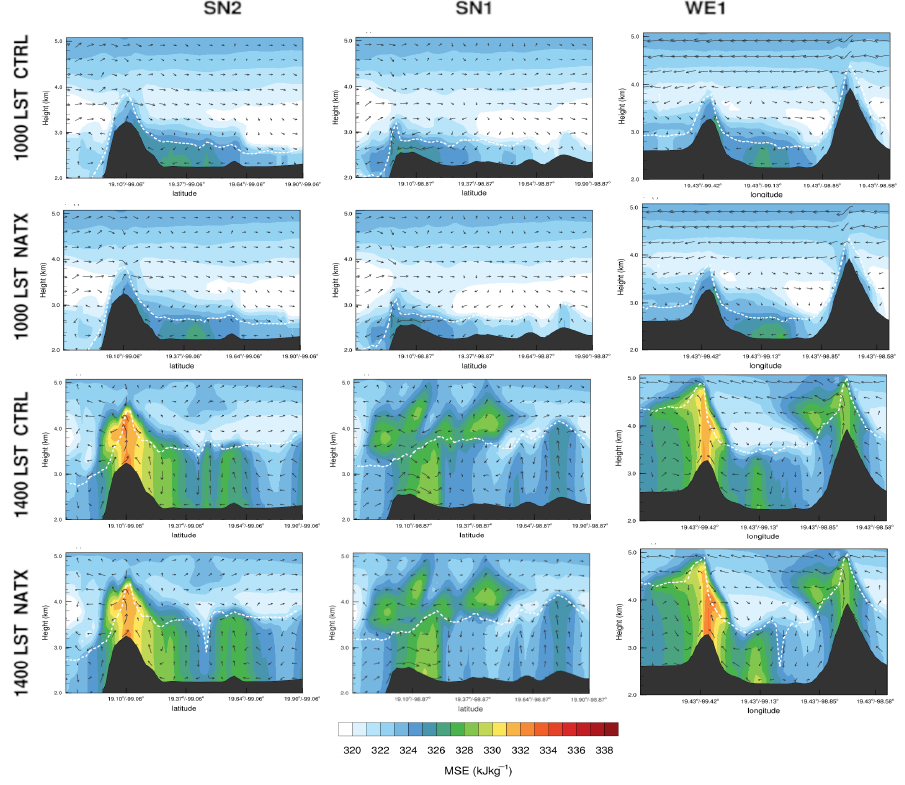
Figure 7. Vertical cross-sections of moist static energy in the CTRL, and NATX simulations for 10 February 2017 at 1000, and 1400 LST. Each panel column represents a transect as defined in Figure 1. The wind field pattern is represented by the vertical and meridional components of the wind for the south-north transects (SN1, and SN2) and zonal wind component for the west-east transect (WE1). In order to facilitate inspection of the fields, the vertical wind component is multiplied by a factor of 10 and the vertical scale is exaggerated compared to the horizontal scale. The white line represents the height in m amsl of the PBL, from the model